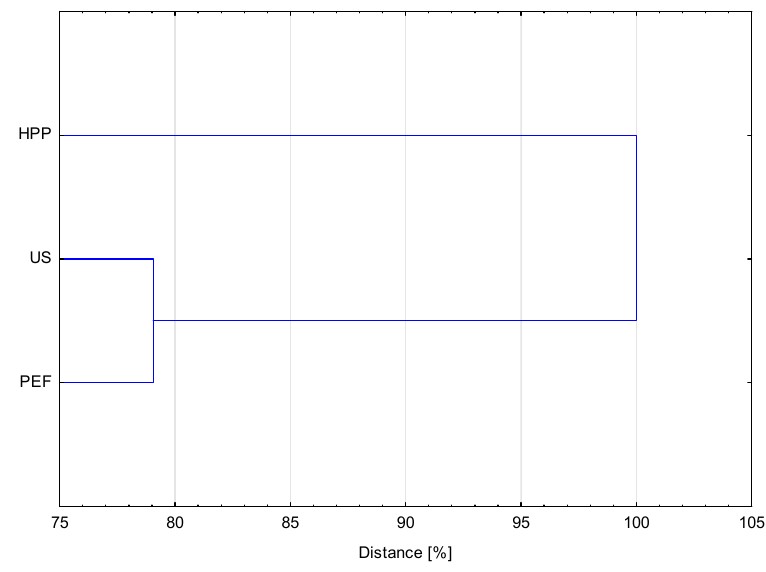
Figure 6. Dendrogram of cluster analysis considering all investigated parameters.